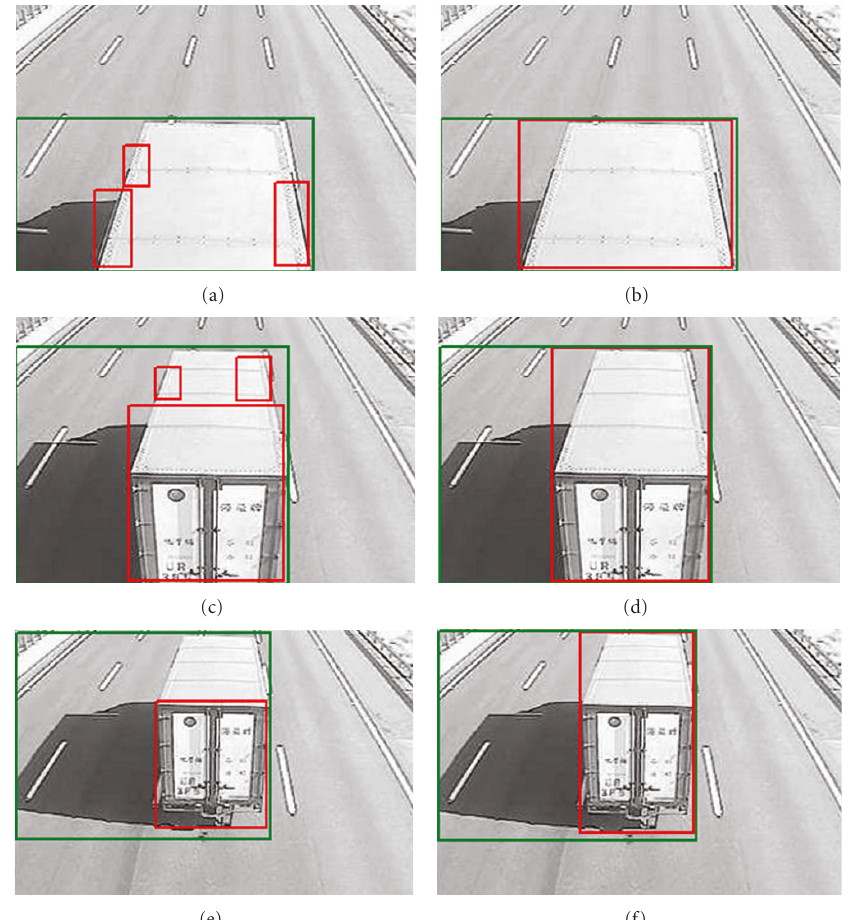
Figure 31: Compared results of not applying and applying gray level-based shadow removal foreground-pixel extraction.